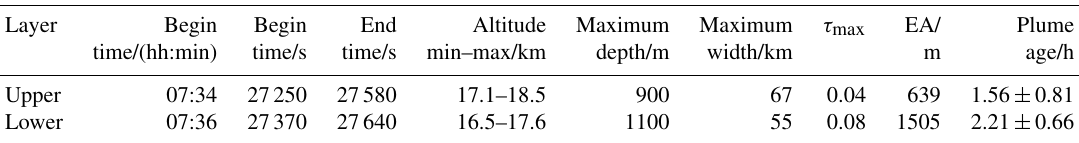
Figure 12. Falcon lidar signals in the vertical plane (“curtain”) above the flight level for a 23min time segment, total 254km, 07:26 to 07:49UTC, 30 November 2005. Top panel: 1064nm backscatter ratio with overlay of potential contrail positions (red: primary; blue: sec- ondary wakes). At t = 27800s, 07:43:20UTC, the black diamond with error bar indicates the cloud-top height derived from AVHRR data. Middle panel: plume ages and total optical depth at 532nm. Bottom panel: color ratio (ratio of extinction at 532 to 1064nm). Table 5. Scales of the two stratospheric anvil cloud layers as seen from the Falcon in lidar backscatter signals with maximum optical depth τ max and total extinction EA, 30 November